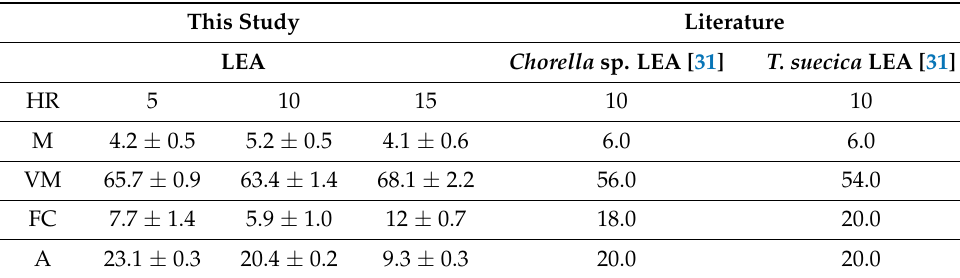
Table 1. Proximate analysis data for LEA from this study and other algal species from literature. This